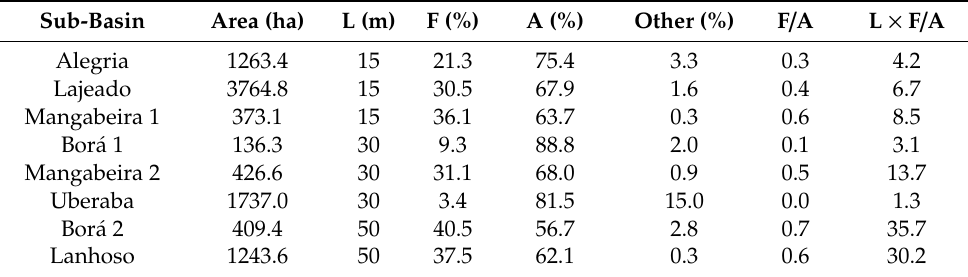
Figure 4. Distribution of studied sub-basins within the Environmental Protection Area of Uberaba River Basin. Table 1. Land use and cover within the studied sub-basins. Symbols: L—approximate average width of riparian bu ff er marginal to the water course, observed in satellite images; F—forest cover (native or managed); A—use for agriculture (sugar cane plantations; natural and managed pastures); Other—other uses or